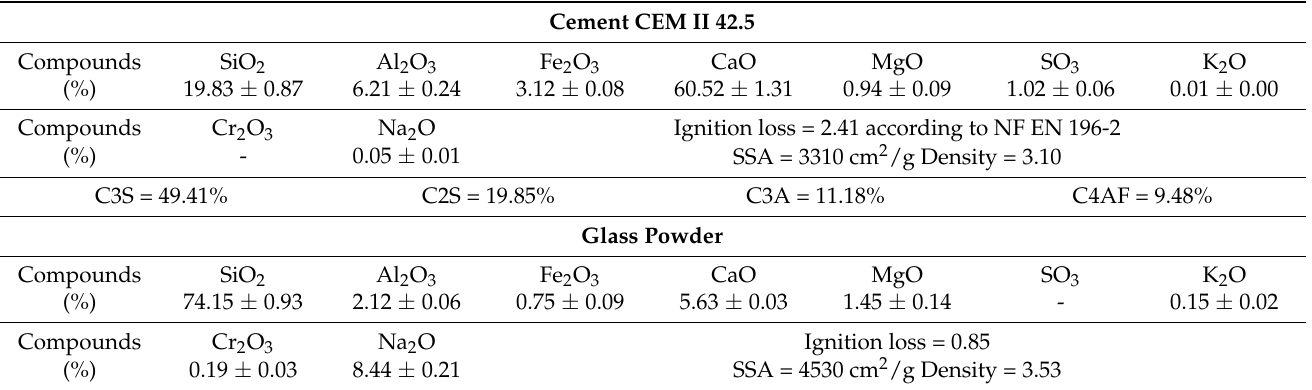
Table 2. Physico-chemical characteristics of cement and glass